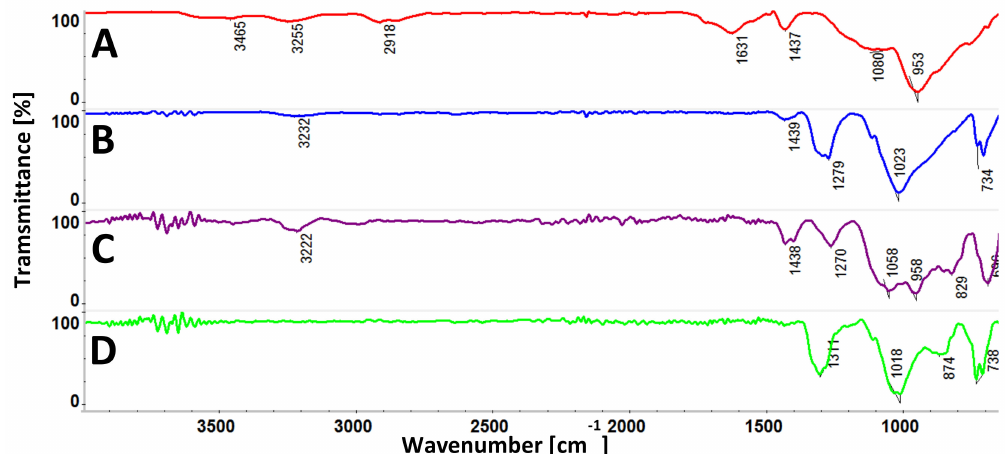
Figure 4. The FTIR spectra of: A ) CM, B ) Co-CMC, C ) Fe-CMC, and D ) Ni-CMC.